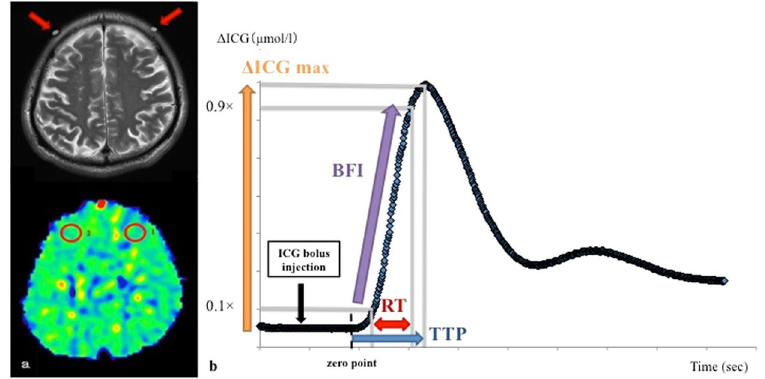
Figure 4. The arrow indicates the site of the optodes for the NIRS procedure on an MRI T2 weighted image ( a , top). The circular regions of interest were placed manually at the site presumed to be measured by NIRS, and rCBF and rOEF were measured on the result of a 15 O-labeled gas PET study ( a , bottom). A representative ICG time-intensity curve showing the parameters used to estimate the regional cerebral perfusion. We set the zero point as the time to rise to + 4 standard deviation of the average ICG concentration in the period 0–10 seconds after intravenous injection, and calculated Δ ICGmax (the maximum ICG concentration), TTP (time to peak: the time between 0 and 100% of the maximum ICG concentration), RT (rise time: the time between 10 and 90% of the maximum ICG concentration), and BFI(blood flow index: Δ ICGmax / RT). Each measured parameter was normalized using the affected-to-unaffected side ratio ( b